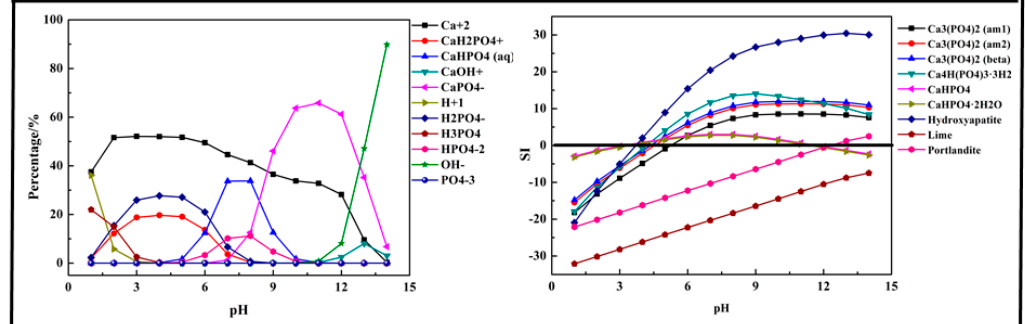
Figure 3. Percentage of species in the Ca-P-H 2 O system at 298 K at ranged pH ((P) = 0.01 mol/L, (Ca 2+ ) = 0.015 mol/L).